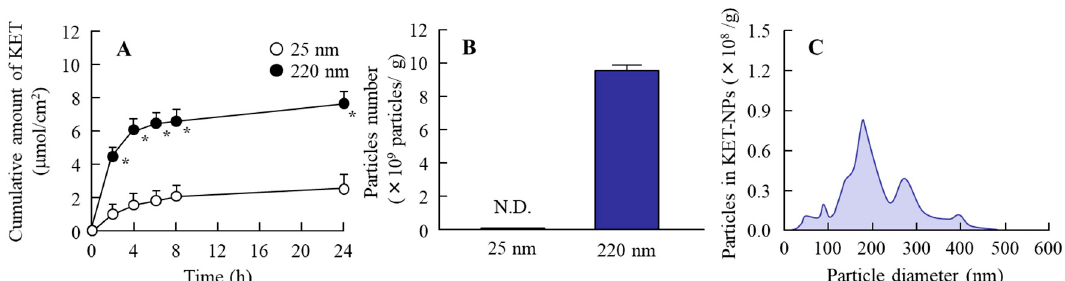
Figure 2. Ketoprofen release from the KET-NPs formulation through 25 nm and 450 nm pore membranes. ( A ) Drug release from the KET-NPs formulation through the membranes; ( B ) Number of ketoprofen particles released from the KET-NPs formulation; ( C ) Particle size frequencies of ketoprofen released from the KET-NPs formulation 24 h after application in the 450 nm pore membrane. The ketoprofen in the Franz diffusion cell (reservoir chamber filled with purified water) after the application of the KET-NPs formulation was measured by HPLC, and the number of particles was counted using NANOSIGHT LM10. Means ± S.E. n = 6. N.D., not detectable. * p < 0.05 vs. 25 nm-pore membrane for each category. Ketoprofen was released from the KET-NPs formulation in the nanoparticle state (mean particle size, 189.3 ± 24.5 nm).